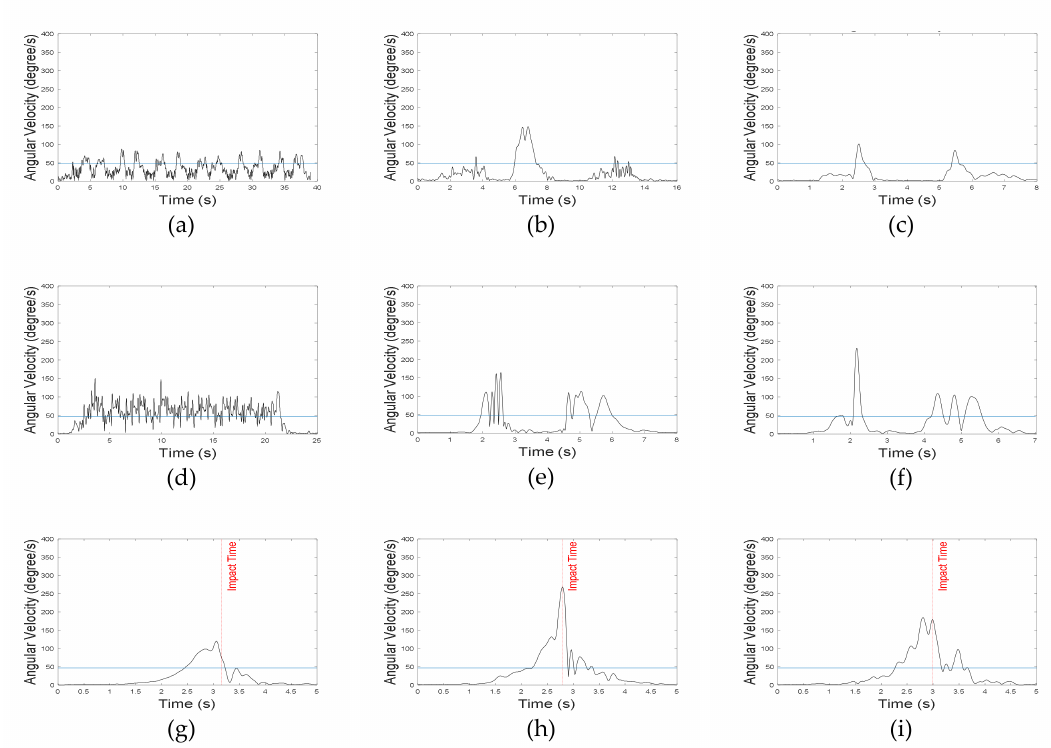
Figure 9. Angular velocity SVM graphs. Less-dynamic motions: ( a ) walking, ( b ) climbing up and down the stairs, and ( c ) slowly sitting on the stool and getting up. Highly dynamic motions: ( d ) jogging, ( e ) quickly sitting on the chair and getting up, and ( f ) quickly sitting on low-height mattress and getting up. Fall motions: ( g ) backward fall, ( h ) lateral fall, and ( i ) twist fall.